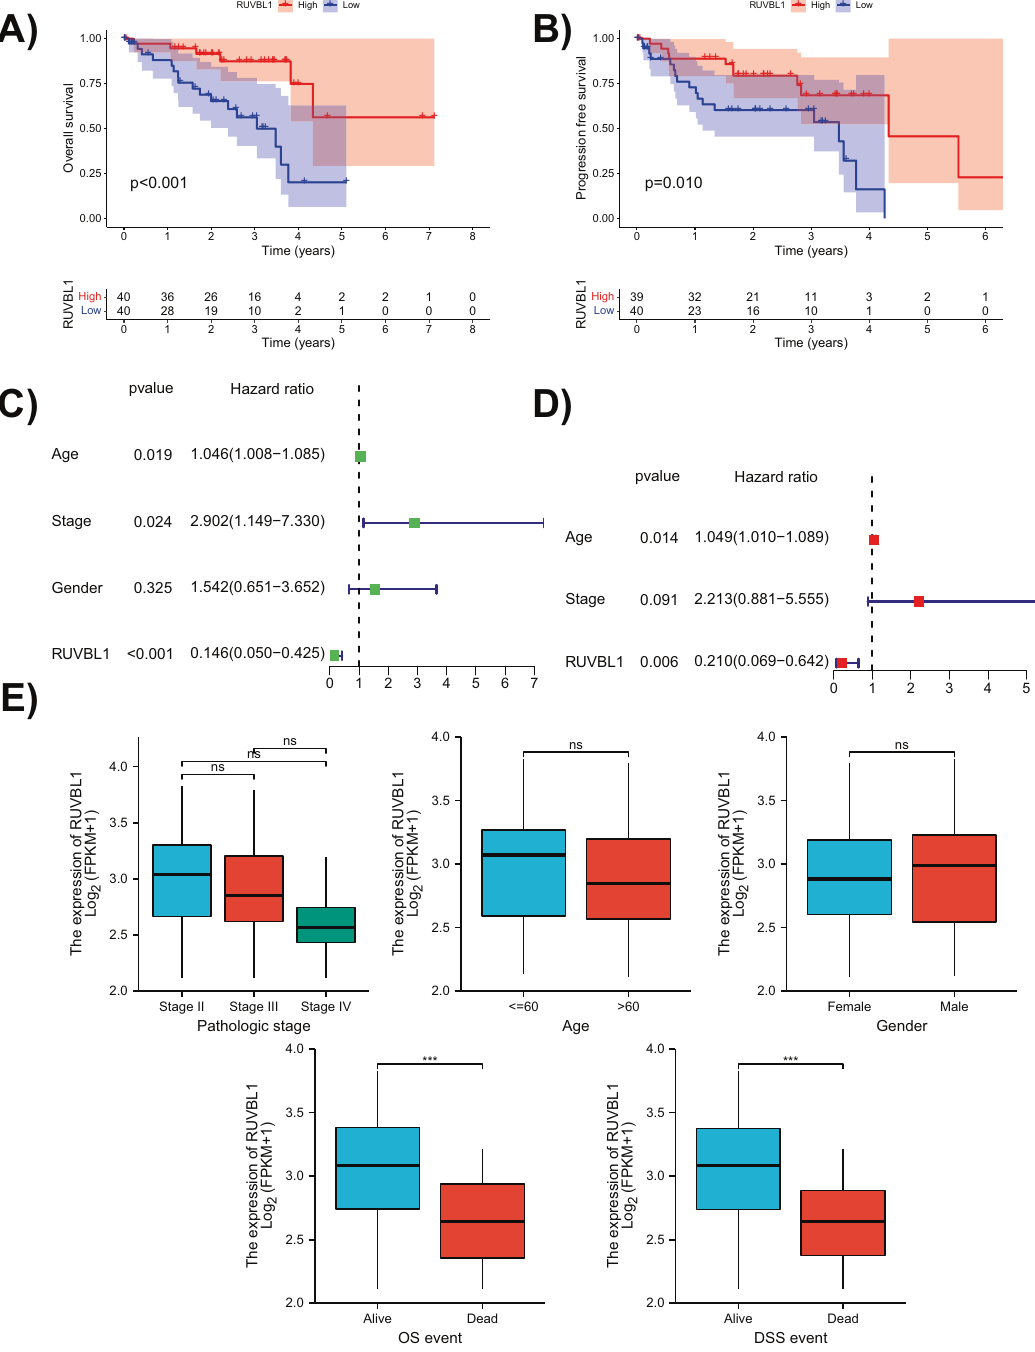
Fig. 2 Correlation between RUVBL1 and prognosis of patients with UVM based on the TCGA database. A Survival analysis of patients with high and low RUVBL1 expression in the TCGA database (the top half is a survival curve diagram, the abscissa is the survival time, the ordinate is the survival rate, red and blue curves indicate the patients with high and low expression of RUVBL1, respectively, p < 0.001 indicates a signi fi cant difference regarding survival time between the two groups; the lower half indicates the number of remaining patients in the two groups at each survival time point. B Progression-free survival analysis of the patients with high and low RUVBL1 expression in the TCGA database (the top half is a progression-free survival curve, the abscissa is the survival time, the ordinate is the progression-free survival, red and blue curves indicate the patients with high and low expression of RUVBL1, respectively, p < 0.05 indicates that RUVBL1 is associated with progression-free survival; the lower half indicates the number of remaining patients in the two groups at each survival time point. C Forest plot of univariate independent prognosis analysis f RUVBL1 and age, stage or gender. D Forest plot of multivariate independent prognostic analysis of RUVBL1 and age or stage (each row represents one factor, p < 0.05 indicates that the factor is associated with survival, HR > 1 means that the point is on the right of the dotted line and represents a high risk factor, HR < 1 means that the point is on the left side of the dotted line and represents a low risk factor; p < 0.05 indicates that the factor serves as an independent prognostic factor). E The correlation analysis of RUVBL1 and each clinical characteristic (the abscissa represents the grouping of the clinical characteristics, the ordinate indicates the expression of RUVBL1, ns indicates no statistical difference between the two groups, *** p < 0.001). Cell Death Discovery (2023)